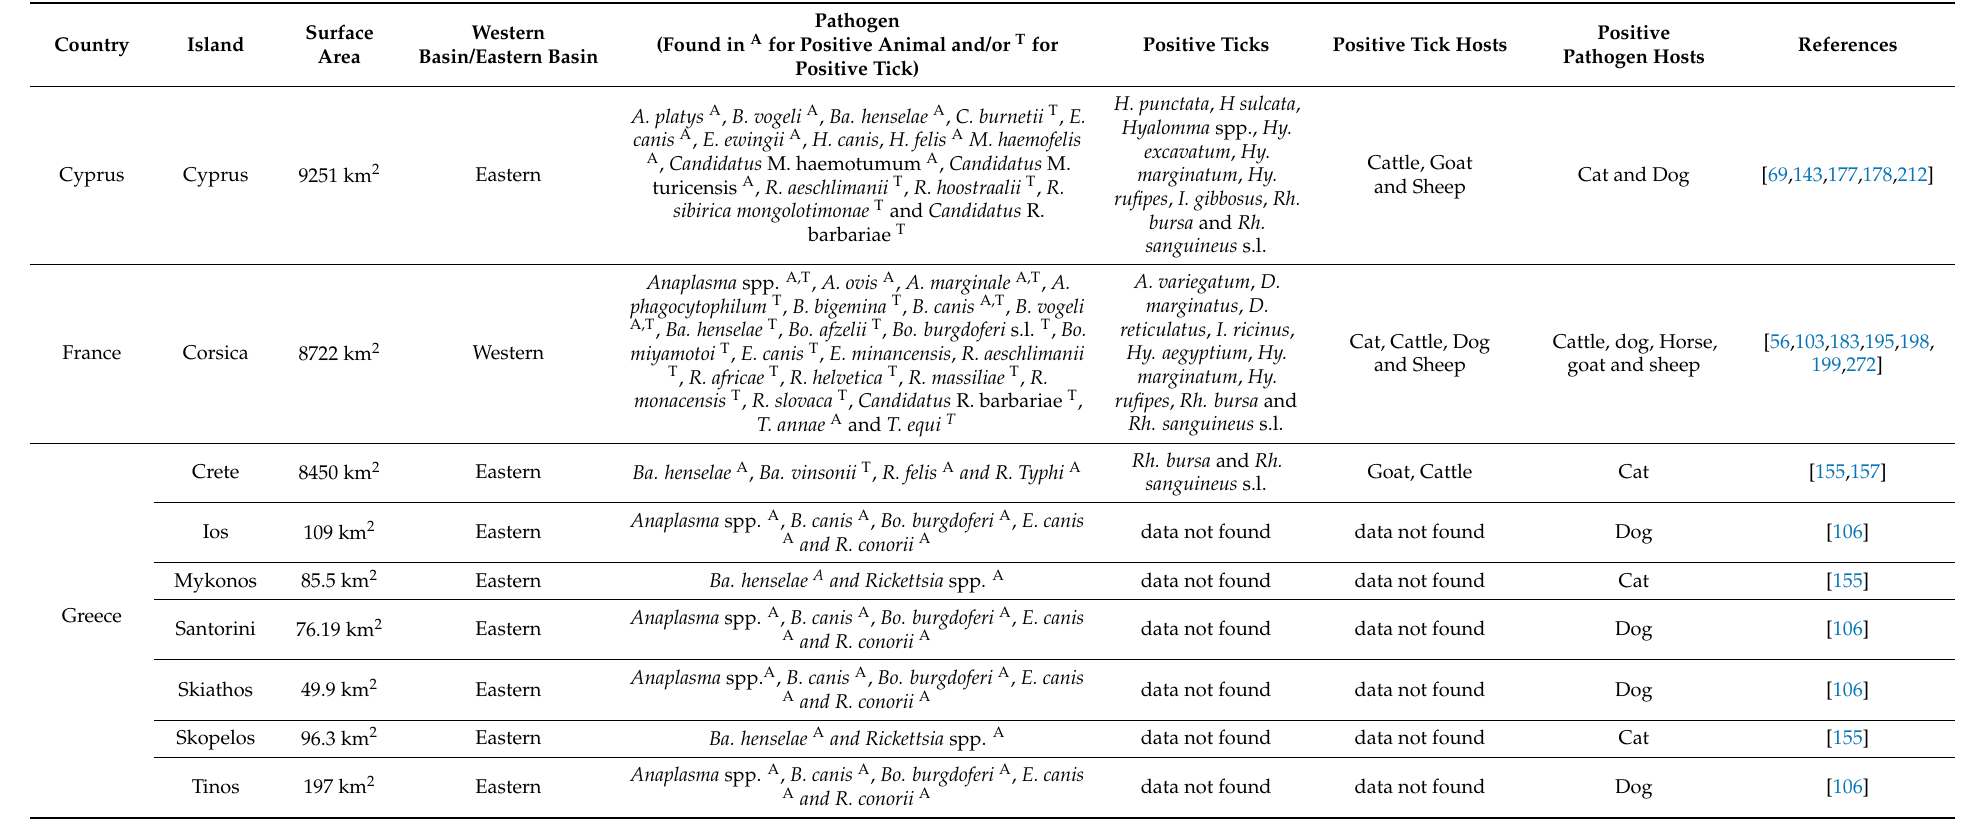
Table 3. Tick-borne pathogens from insular domestic animals or engorged ticks collected from these animals in the Mediterranean